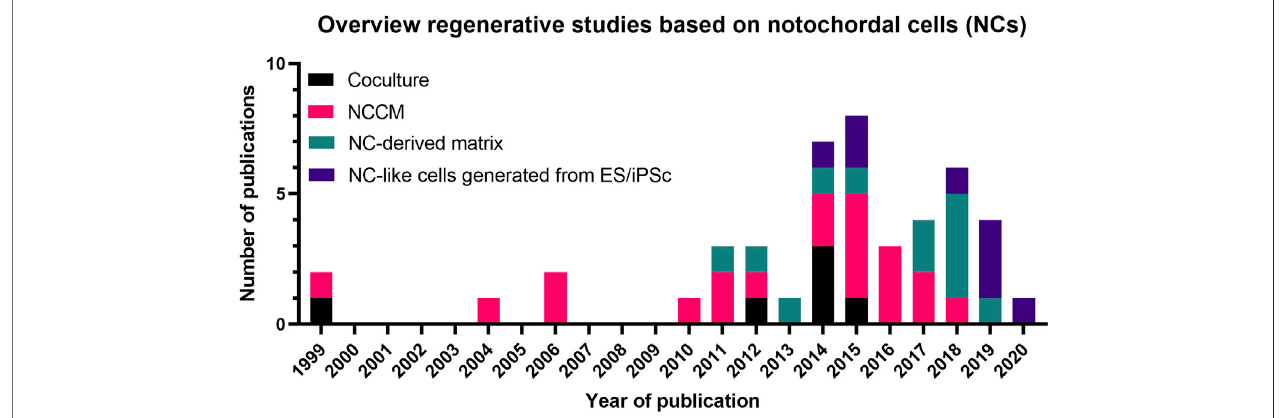
FIGURE 6 | Overview of the number of studies (1999 – 2021) on the regenerative potential of Notochordal cells. A trend is observed in time from mainly coculture- and NCCM-based studies towards NC-derived matrix and NC-like cell generation studies. Details of these studies are provided in Supplementary Materials S1, S2 and the main text. NCCM, Notochordal cell-conditioned medium; NC, Notochordal cell; ES, embryonic stem cell; iPSC, induced pluripotent stem cells.